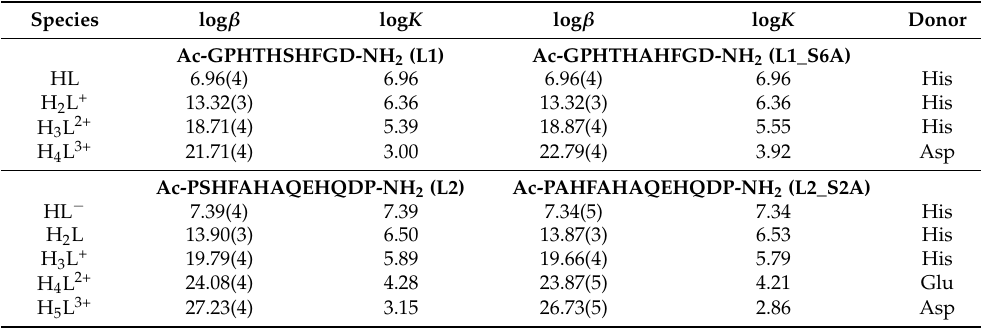
Table 1. Protonation constants for all investigated ligands at T = 298 K and I = 0.1 M (KCl). Values in parentheses are standard deviations on the last significant